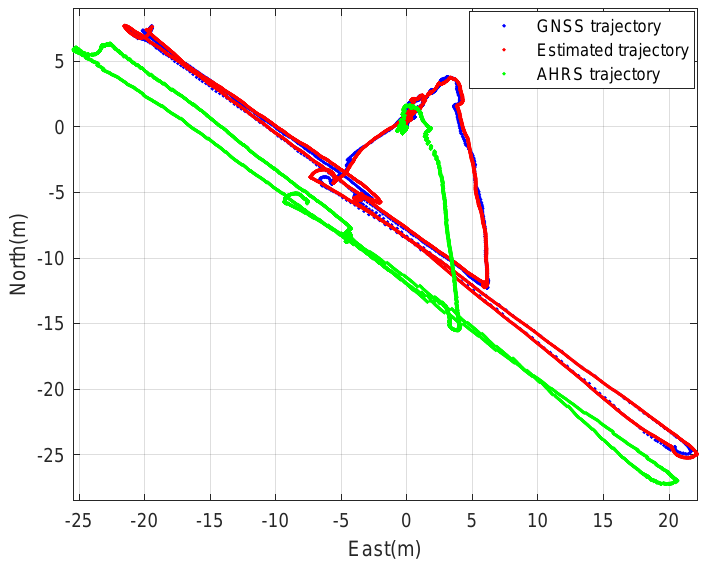
Figure 19. The 2D trajectory of the athlete: comparison with Microstraion’s